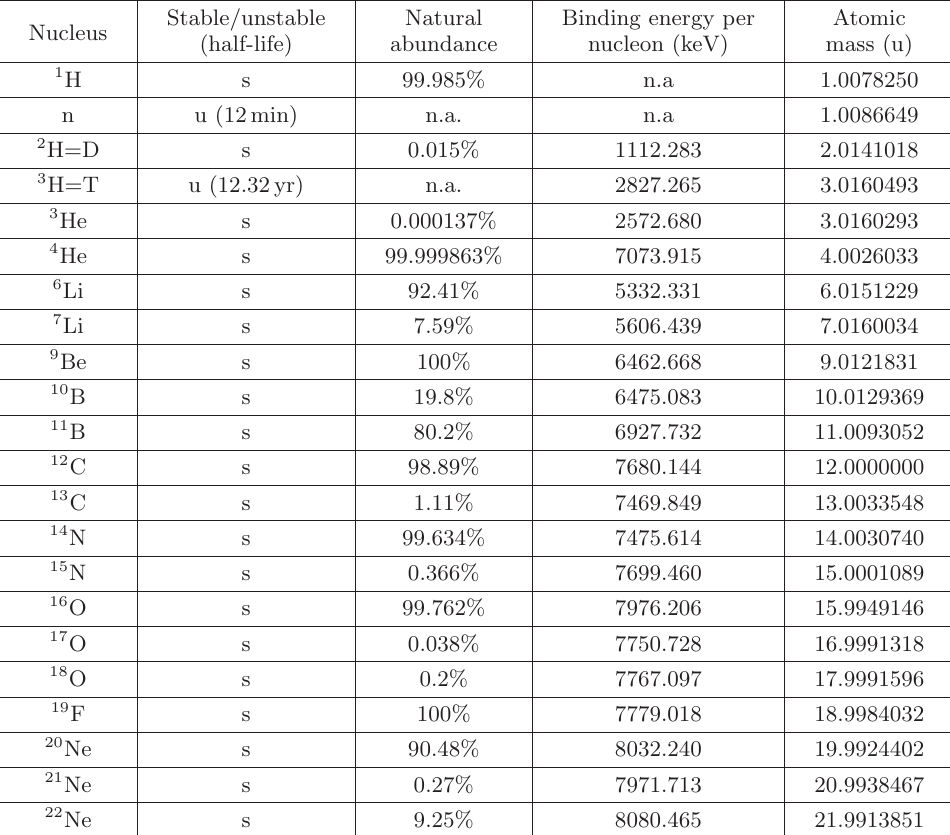
Table II. – Atomic mass and binding energy per nucleon [42] , stability and natural abundance for light nuclides. Note the remarkable absence of stable nuclides with mass number 5 and 8